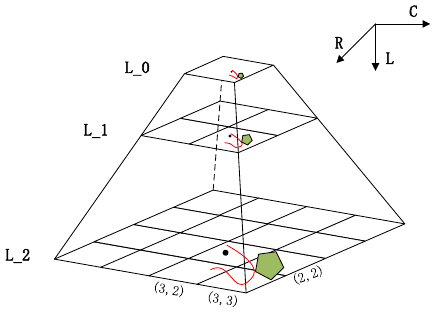
Figure 7. The schematic diagram of the tile pyramid model.